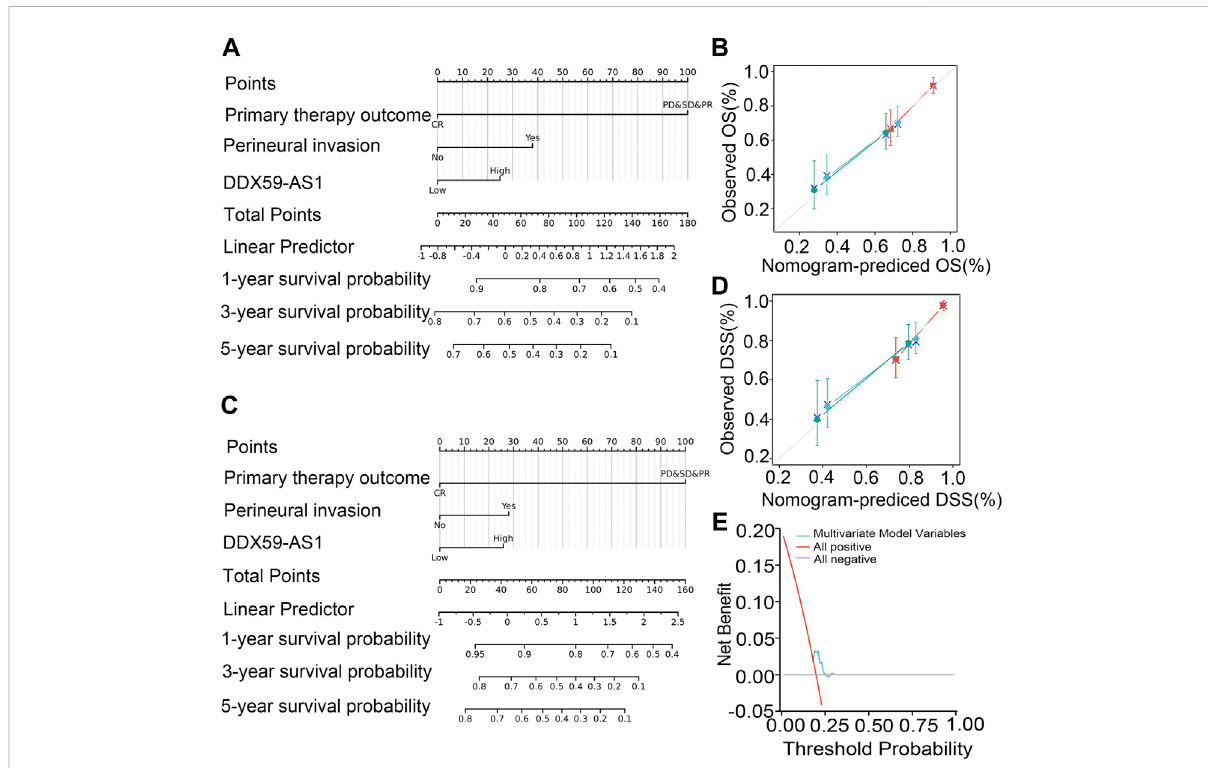
FIGURE 7 Relationship between DDX59-AS1 and other clinical factors with overall survival (OS). (A) Nomogram for predicting the probability of 1-,3-, and 5-year OS for OSCC patients; (B) Calibration plot of the nomogram for predicting the OS likelihood; (C) Nomogram for predicting the probability of 1-,3-, and 5-year DSS for OSCC patients; (D) Calibration plot of the nomogram for predicting the DSS likelihood; (E) DCA curve for evaluating